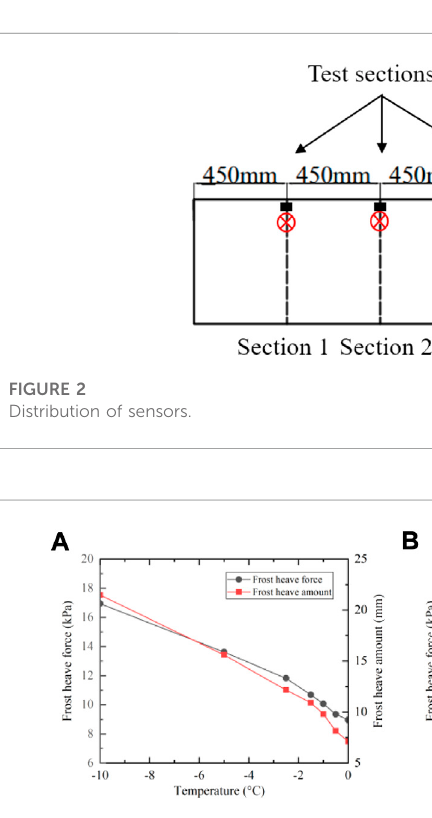
FIGURE 3 Change rules of frost heave force and amount in group A. (A) Section 1. (B) Section 2. (C) Section